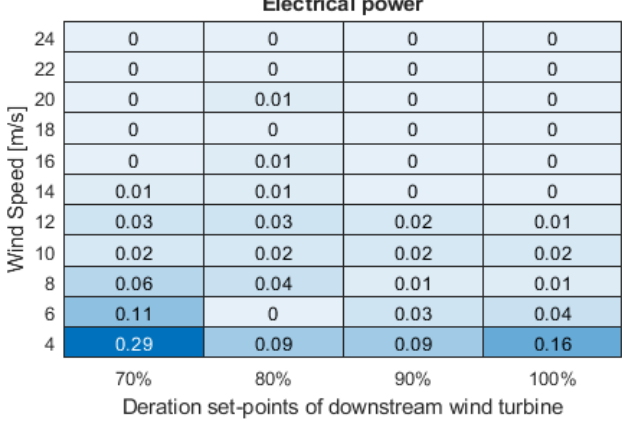
Figure 8. Test error of GPR for all DELs of different deration set-points of downstream wind turbine ( x -axis) at I ref = 0.12 with normal operating upstream wind turbine. The model was trained and tested by all input data set.